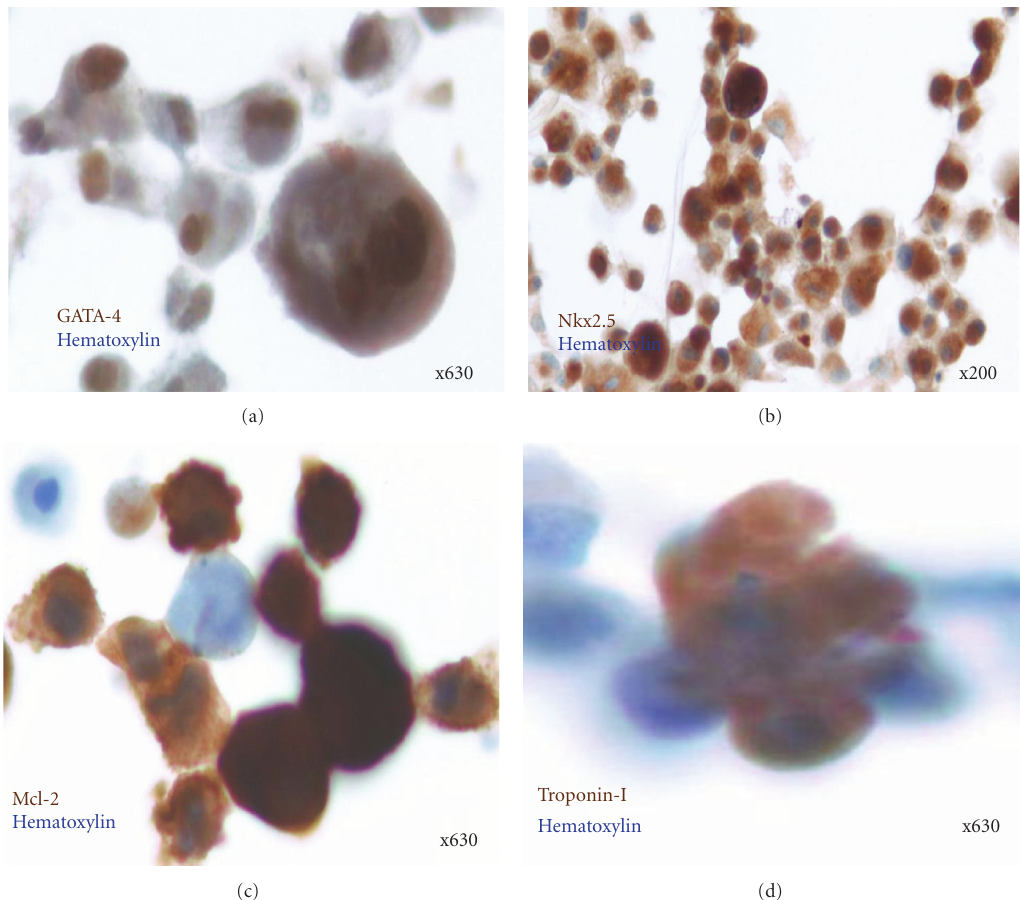
Figure 4: In vitro di ff erentiation of hc-kit positive cells. Representative photomicrographs of emigrated and immune-selected hc-kit positive cells demonstrating expression of mesodermal markers (GATA 4 and Nkx 2.5) and cardiac di ff erentiation (Mcl-2 and troponin-I). Monoclonal antibody binding was visualized using DAB reporter chromogen (brown) with nuclear hematoxylin counterstain (blue). (a) GATA 4 positive hc-kit positive cells. Magnification × 630. (b) Nkx 2.5 positive hc-kit positive cells. Magnification × 200. (c) Mcl-2 positive hc-kit positive cells at Day 28. Magnification × 630. (c) Troponin-I positive hc-kit positive cells at Day 28. Magnification × 630. Note: hc-kit positive cells are positive for the four